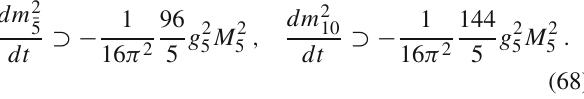
Fig. 3 Contributions to a μ e γ R . On the left hand side (of the equality), we depict the diagram in the mass eigenstate basis, and on the right hand side, the diagrams are split in the interaction basis. The external